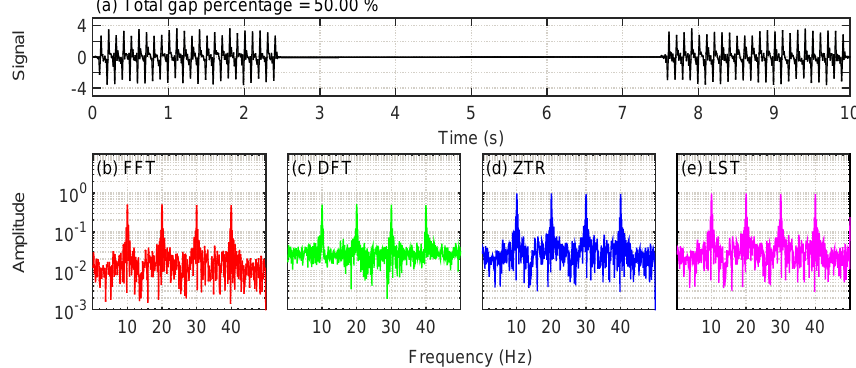
Figure 3. Case study for the SLG test applied to the synthetic data. Panel (a) shows the windowed signal with TGP of 50% and the other panels are the same as in Fig. 2. The windowing procedure, using a Tukey window, is applied to the two parts of the signal around the gap, thus canceling the offset on either side of the